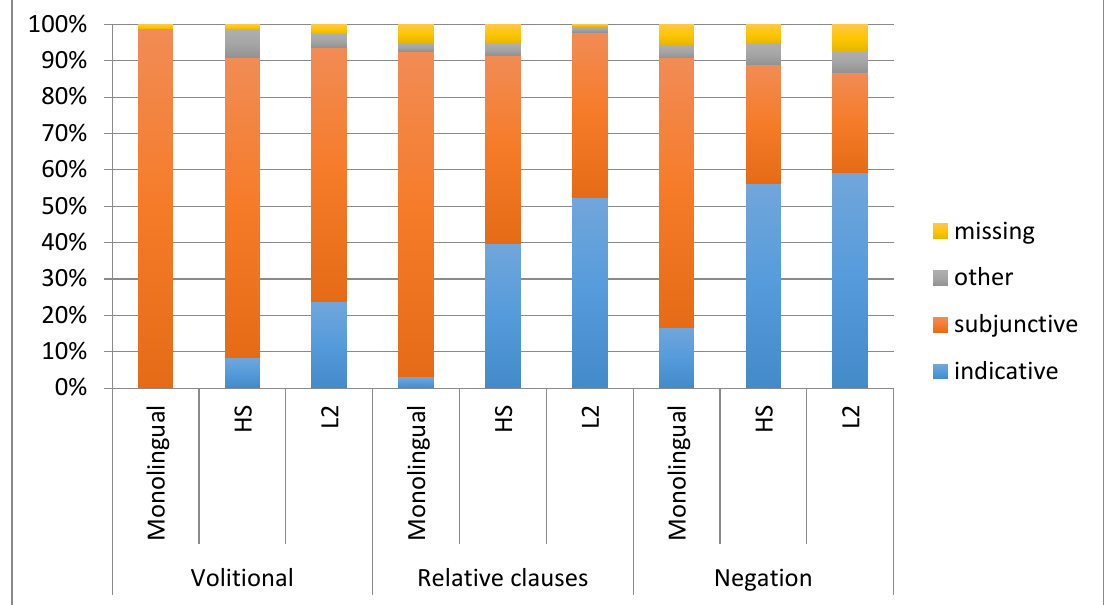
Figure 1. Percentages of indicative (infelicitous), subjunctive (felicitous) and other responses per condition per group. HS: heritage speakers.